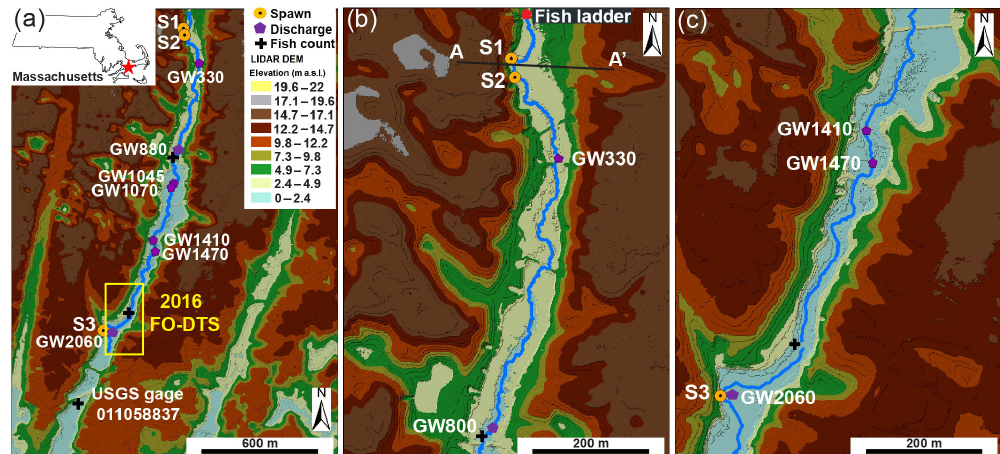
Figure 2. Lidar elevation data show the linear valley terrain of the Quashnet River study reach, as shown in panel (a) with Spawn (S1, S2, S3) locations and major open-valley seepage zones identified. The enlarged view of panel (b) shows the more narrow upper valley zone where Spawn 1 and 2 are located at the base of a steep cutbank and the topographic transecting point of Fig. 9 (A–A’) is noted. Finally, panel (c) displays the lower open-valley reach where Spawn 3 is located along a major